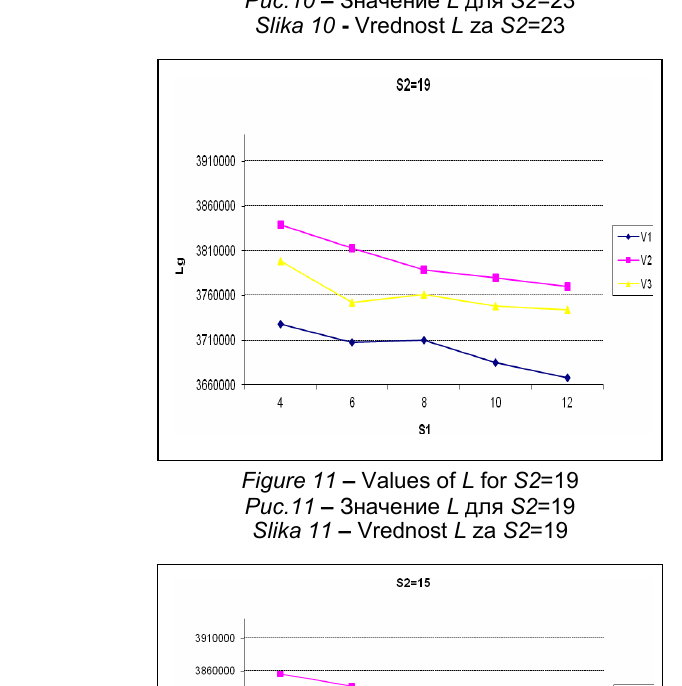
Figure 11 – Values of L for S2 =19